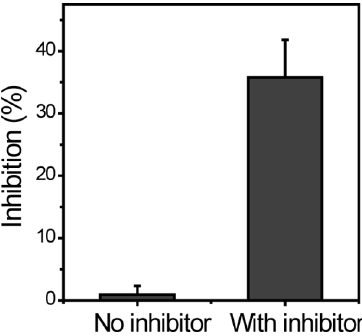
Figure 7. Inhibition of HCV NS3 protease by an RNA aptamer. An HCV NS3 protease inhibitory RNA aptamer was prepared and tested. Cells co-transfected with vectors encoding type I MBR and HCV NS3 protease were and treated with the RNA aptamer. The inhibition ratio was determined from the number of cells exhibiting a dispersed pattern relative to the total number of cells